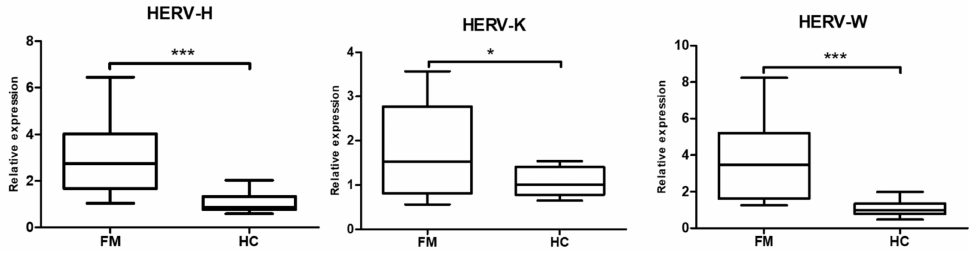
Figure 1. HERVs are overexpressed in FM. RT-qPCR amplification of HERV-H, HERV-K and HERV-W using total RNA from PBMCs is shown (N = 14 / group) (*** p < 0.001; * p < 0.05). Primer sets are detailed in Table 2 and conditions used described in Methods. Relative expression levels were calculated as 2 − ∆∆ C t values using GAPDH levels as reference. Group means and SEM values are shown.